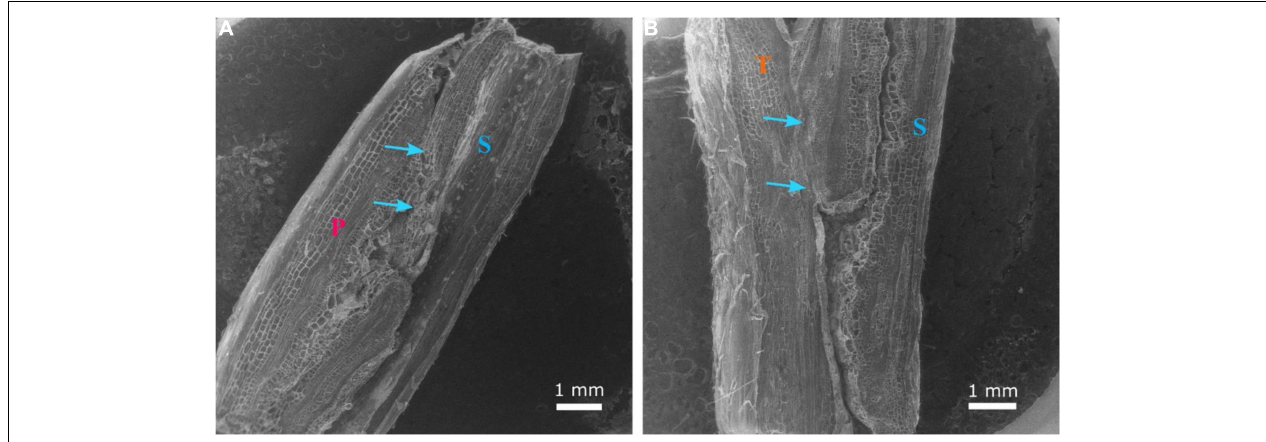
FIGURE 7 | Longitudinal section of the graft union between watermelon cultivar ‘Secretariat’ (S) grafted onto rootstock ‘Pelop’ (P; A ) and ‘Tetsukabuto’ (T; B ) at 25 days after grafting. The scion/rootstock tissue union was complete, with xylem vessels connecting rootstock and scion (blue arrows).